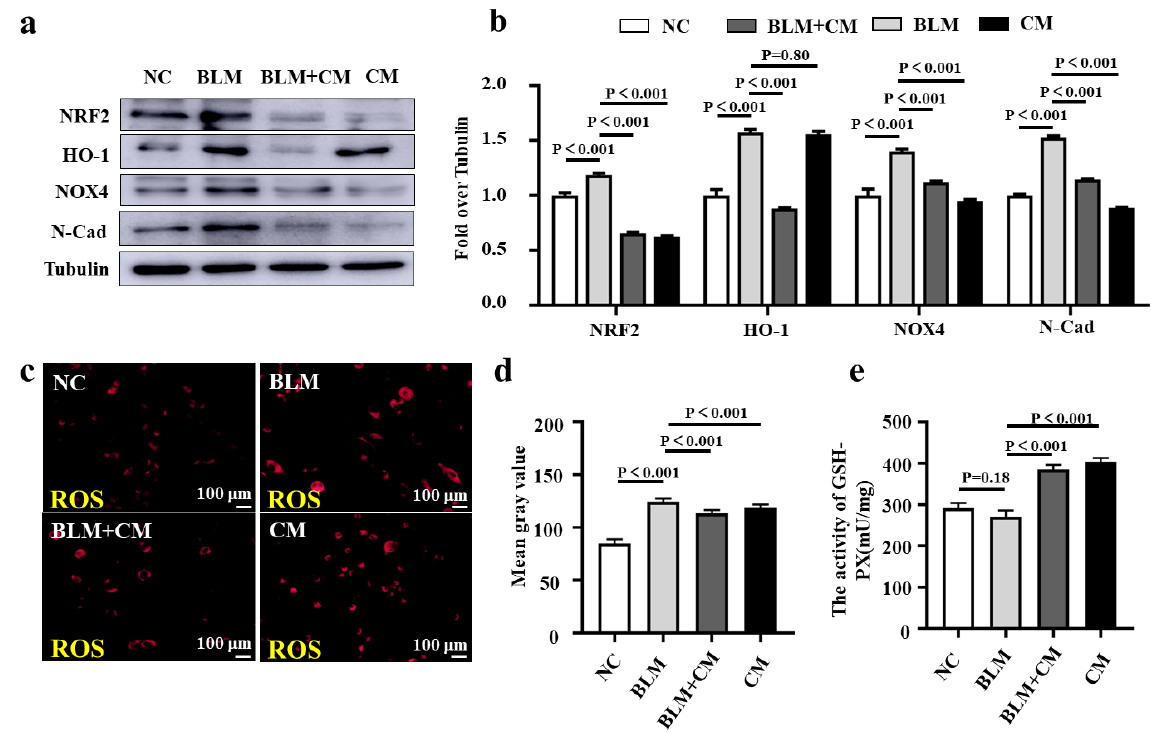
Figure 3. hESC-MSC-IMRC-CM reduces the BLM-induced oxidative stress and EMT in A549 lung epithelial cells. ( a ) Representative immunoblots showed that hESC-MSC-IMRC-CM could reduce BLM-induced A549 cells oxidative injury by decreasing the expression of NRF2, HO-1, NOX4, and EMT markers’ N-Cad. ( b ) The relative levels of NRF2, HO-1, NOX4, and N-Cad proteins as evaluated by a densitometric analysis in ( a ). ( c ) Representative images of A549 cells treated with indicated conditions for 48 h and stained with CellROX ® Orange reagent. hESC-MSC-IMRC- CM significantly reduced the ROS production compared to the BLM group. ( d ) Mean gray value of ROS production in ( c ). ( e ) hESC-MSC-IMRC-CM increased glutathione peroxidase (GSH-PX) production in A549 cells compared to untreated controls. Data in ( b , d , e ) represent mean ± SD of three independent experiments (N = 3), as analyzed by GraphPad prism Two-way ANOVA Tukey’s multiple comparisons test. Scale bars in ( c ), 100 µ